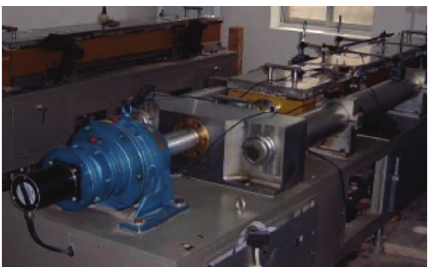
Figure 6: Temperature stress testing machine.